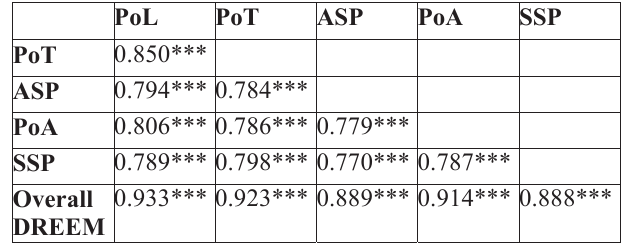
Table-4 : Correlation of subscales and overall scale. *** Correlation was said to be significant at the 0.01 level